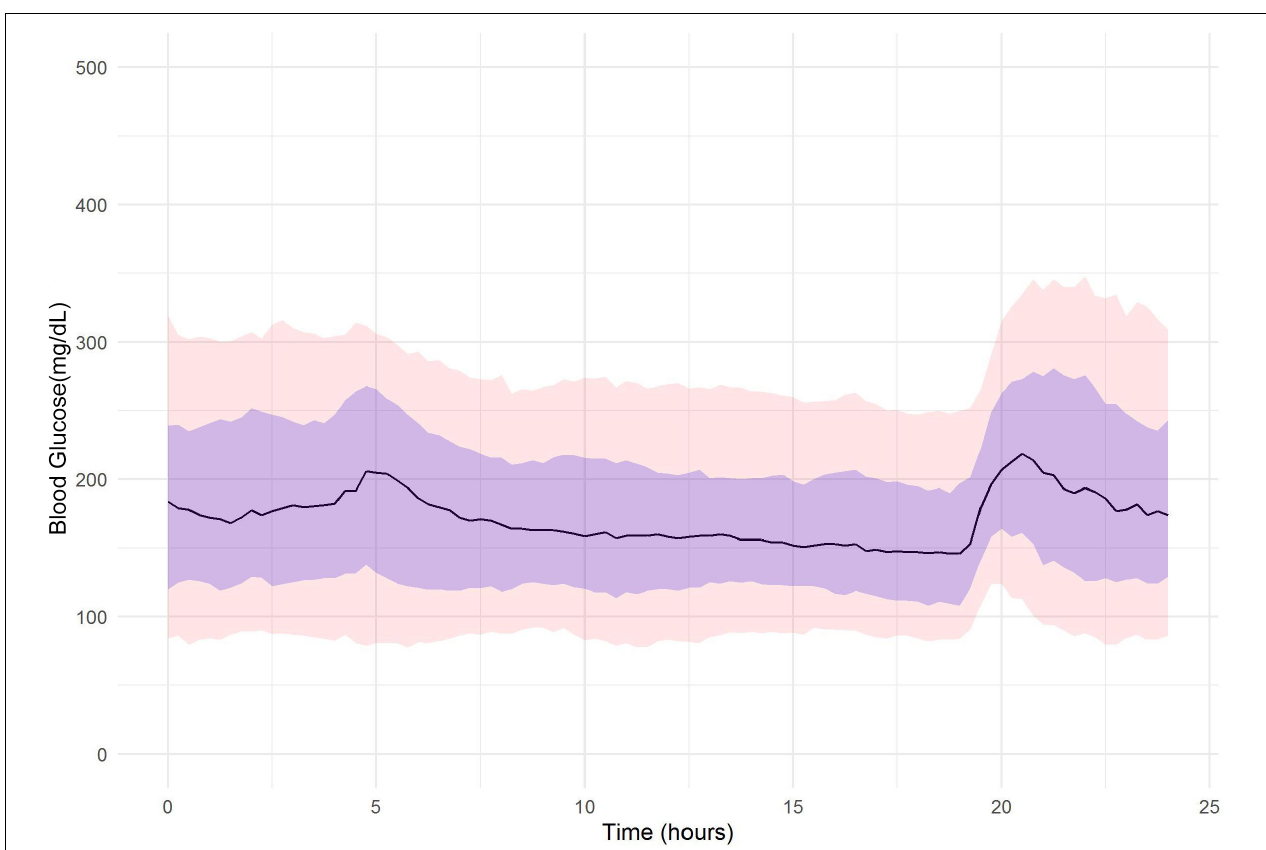
FIGURE 3 | FGM glucose profile ( n = 24) in 30 days during Ramadan and during COVID-19 lockdown (24 April 2020 – 23 May 2020). Line indicates median glucose and purple shaded area shows 25 and 75th percentiles. Pink area denotes 10 and 90th